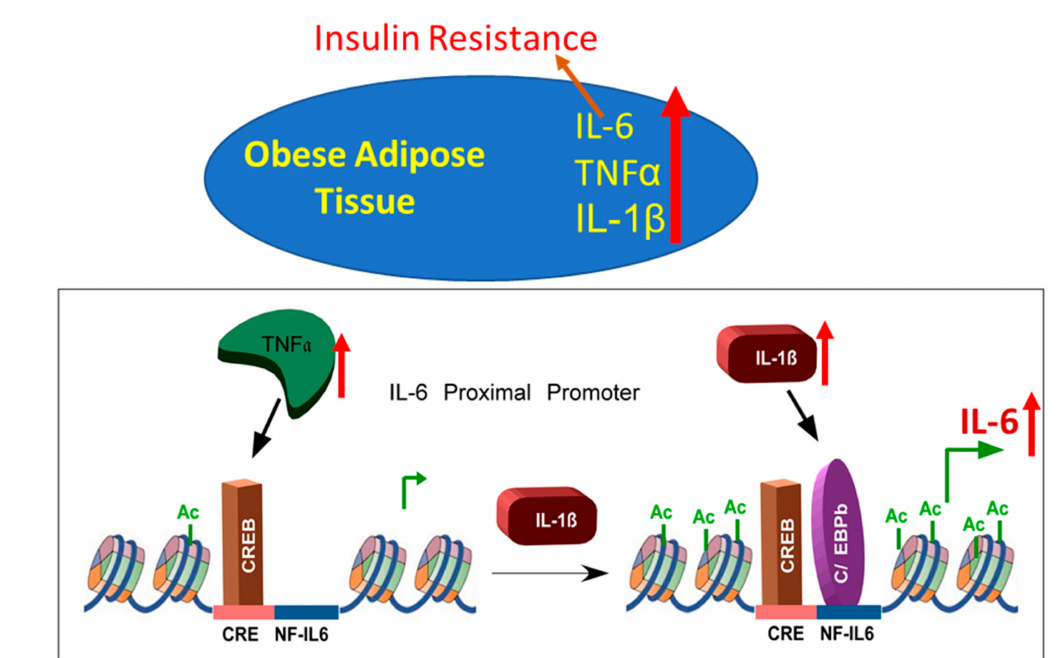
Figure 6. Schematic illustration of signaling pathway underlying IL-1 β /TNF α -induced expression of IL-6 in